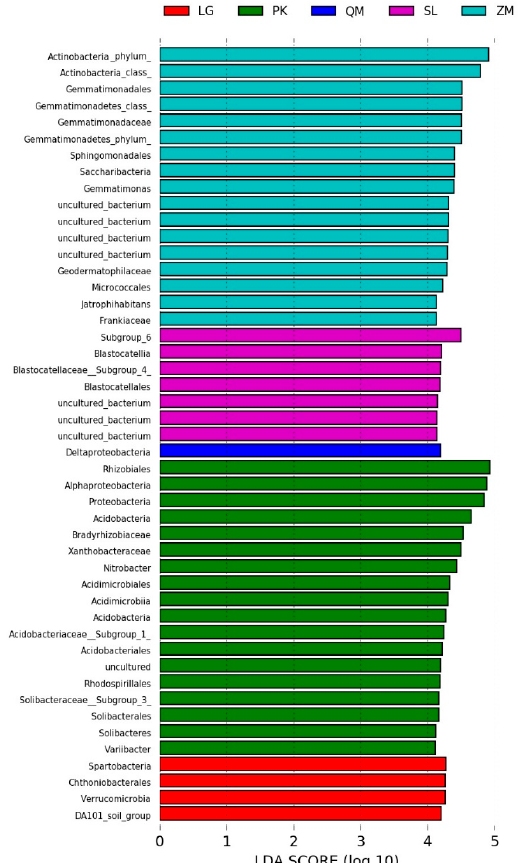
Figure 3. The LEfSe method was used to identify significant bacteria in soils with different land use types. The vertical coordinate is the taxonomic unit with significant differences between the groups, while the horizontal coordinate is a bar chart to visually show the linear discriminant analysis (LDA) displays the LDA score (log 10) of the corresponding taxonomy unit. Bar graph reports the group of samples with higher abundance corresponding to the taxonomy unit. QM; Quercus mongolica ; LG: